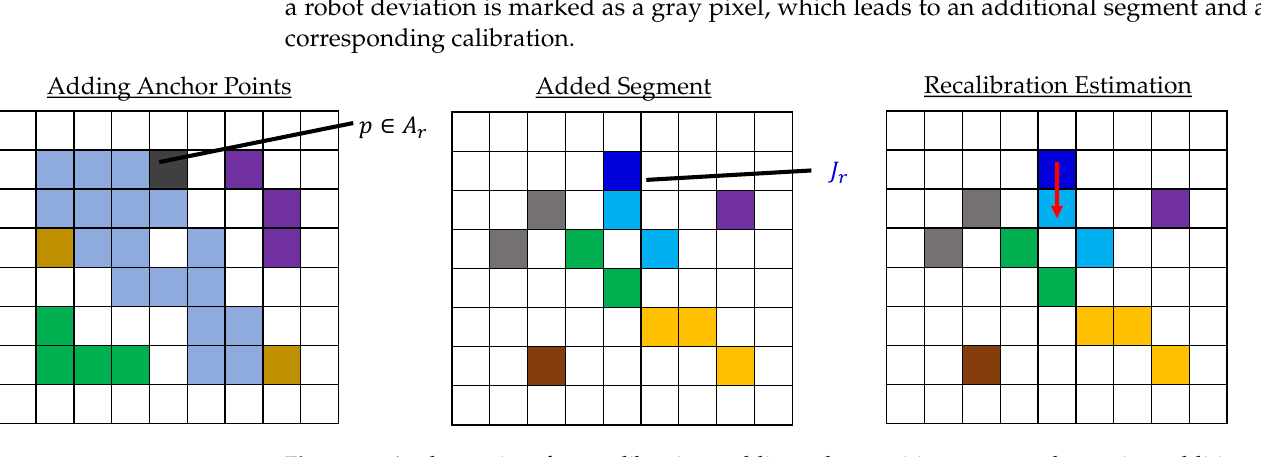
Figure 6. Anchor points for recalibration: adding robot position as an anchor point, additional segment during constrained shrinking, recalibration to reduce the additional segment.